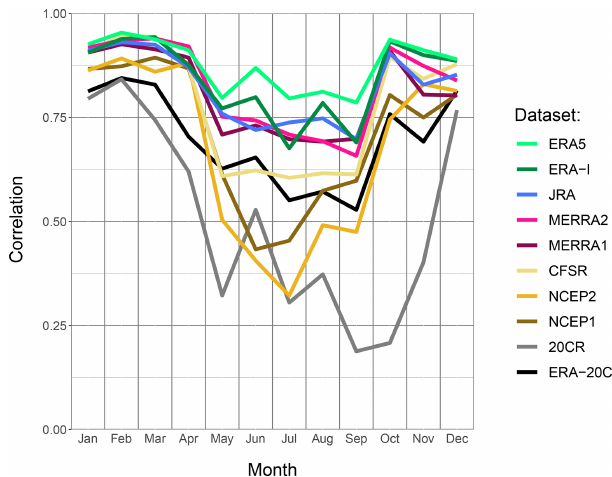
Figure 5. Daily correlation, per month, between APHRODITE-2 and each reanalysis, in the upper Indus. The period considered is